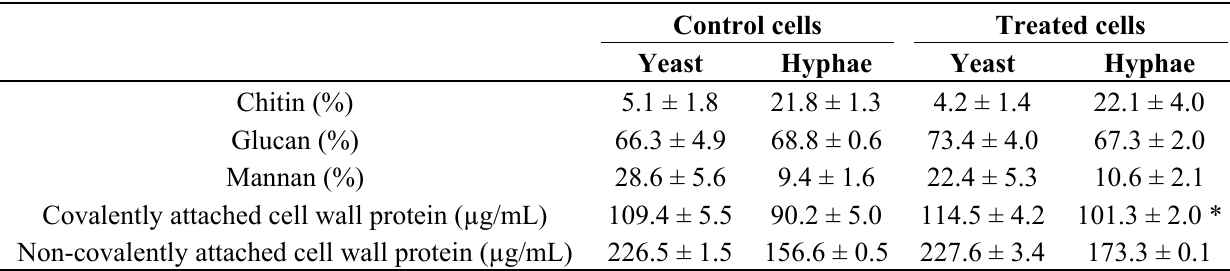
Table 4. Cell wall assay results comparing non-treated and casuarinin fraction treated C. albicans